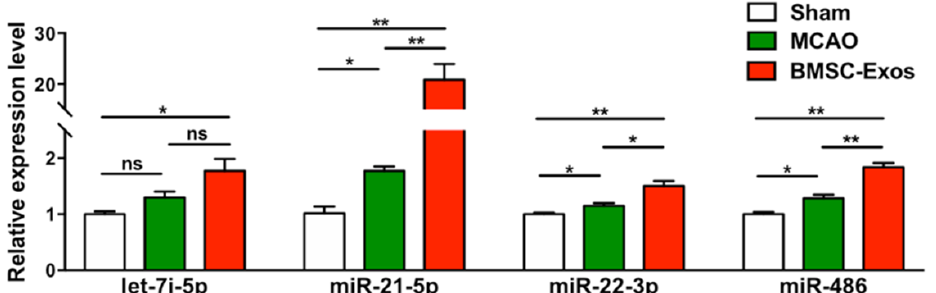
Figure 6. The expression levels of miRs in ischemic brains were determined by qRT-PCR. n = 3/group. * p < 0.05. ** p < 0.01, ns, no significance; BMSC-Exos, bone marrow mesenchymal stem cell- derived exosomes; MCAO, middle cerebral artery occlusion. exosomes; MCAO, middle cerebral artery